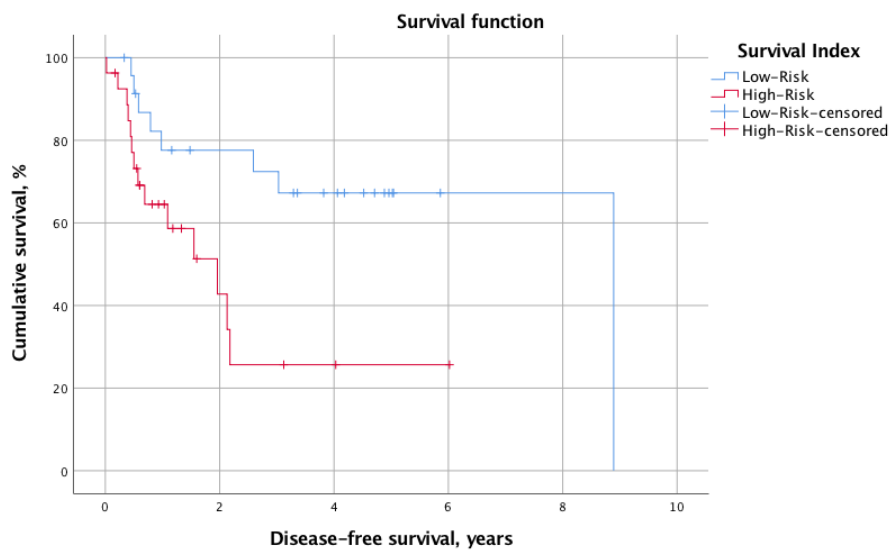
Figure 2. A Kaplan–Meier survival curve showing the DFS for patients stratified into the low-SI ( n = 24, SI 0–2) and high-SI ( n = 27, SI 3–6) groups. The mean DFS was shorter in the low-risk SI group (mean DFS 6.4 years, 95% CI 4.8–8.0 vs. 2.4 years, 95% CI 1.3–3.5). We tested it for statistical significance with the log-rank test, which revealed a significant difference in OS between groups ( p = 0.013). DFS, disease-free survival; SI, survival index; CI, confidence interval.